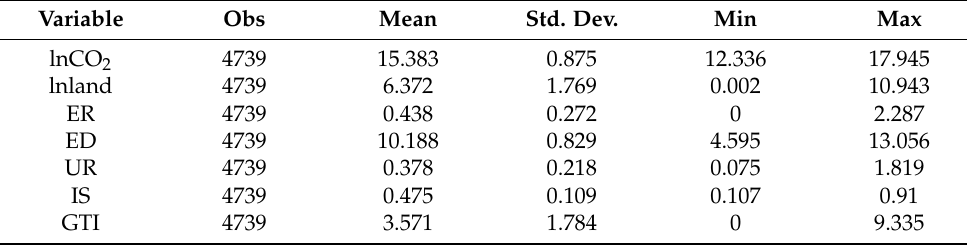
Table 1. Descriptive